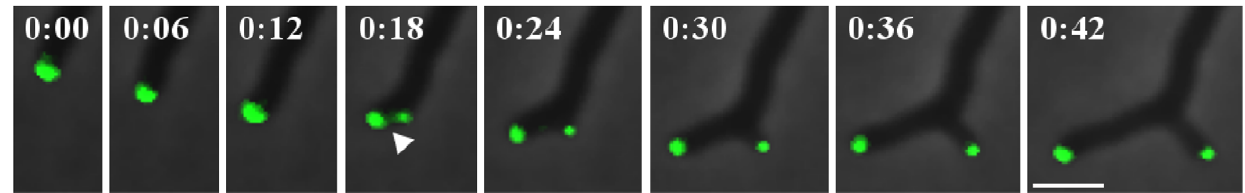
Figure 3. Example of branching at almost zero distance from the tip. The model indicates that this is due to tip-focus splitting events (arrow) where N 0 is greater than N br . Time in hours:minutes. Scale bar: 3 m m .